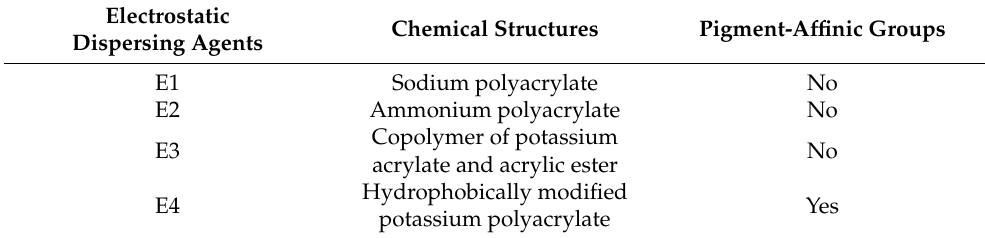
Table 2. Chemical nature of the steric dispersing agents. Steric Dispersing Agents